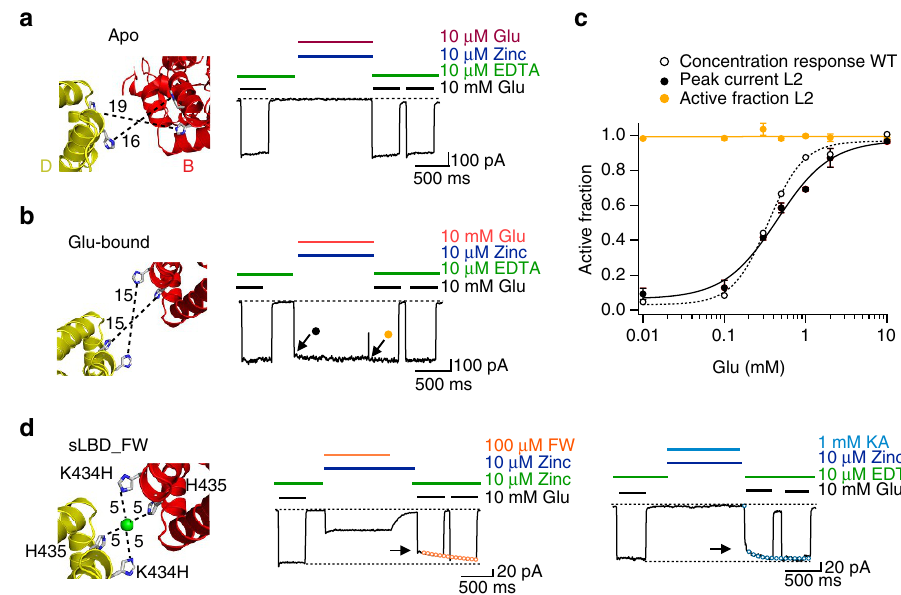
Figure 2 | L2 traps selectively in presence of partial agonists but not in the Apo or the fully active states. ( a , b ) Left panels show the L2 mutant models based on the apo (PDB, 4u2p) and the fully active (PDB, 4yu0) structures. The trapping histidines in these models are too distant (distances are measured between the imidazole N atoms of residues His434 and His435 in subunits B & D) to allow trapping. The right panels show patch clamp experiments at low concentrations of glutamate of 10 m M, testing the Apo state and 10mM, testing the full activated state after the application of CuPhen. As predicted from the modelled histidines we do not observe changes in the active fraction. ( c ) Dose–response curves in Glutamate and 100 m M CTZ for WT GluA2 ( EC 50 ¼ 450 ± 70 m M) (open circles), the peak current, measured at the beginning of the application of Zn 2 þ for the mutant L2 (closed circles) ( EC 50 ¼ 350 ± 30 m M). Zinc did not modify currents and the active fraction following zinc application (yellow circles) was fit by a linear function (c ¼ 0.99; n ¼ 4). ( d ) In the left panel, the L2 mutation modelled into the sLBD_FW structure could allow coordination of a fictive Zn 2 þ ion (green sphere) by K434H and H435 from subunits B and D with minimal conformational change. Dashed lines indicate distances between fictive Zn 2 þ and the imidazole N atoms. Trapping after the application of 100 m M FW and 10 m M Zn 2 þ (left panel) and 1mM KA and 10 m M Zn 2 þ (right panel). Arrows indicate the reduction of the current after trapping in presence of Zn 2 þ . Open circles indicate double exponential fits of the recovery after